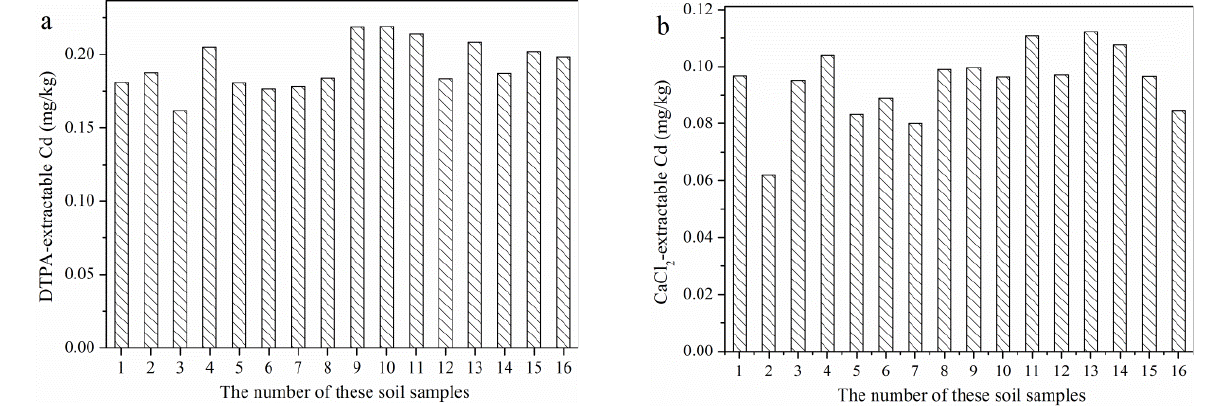
Figure 3. The bioavailable Cd in these paddy soils (mg/kg). ( a ): DTPA ‐ extractable Cd; ( b ): CaCl 2 ‐ extractable Cd. Table 2. Relationship between the bioavailable Cd and selected soil properties. Total Cd pH OM Available K Available P